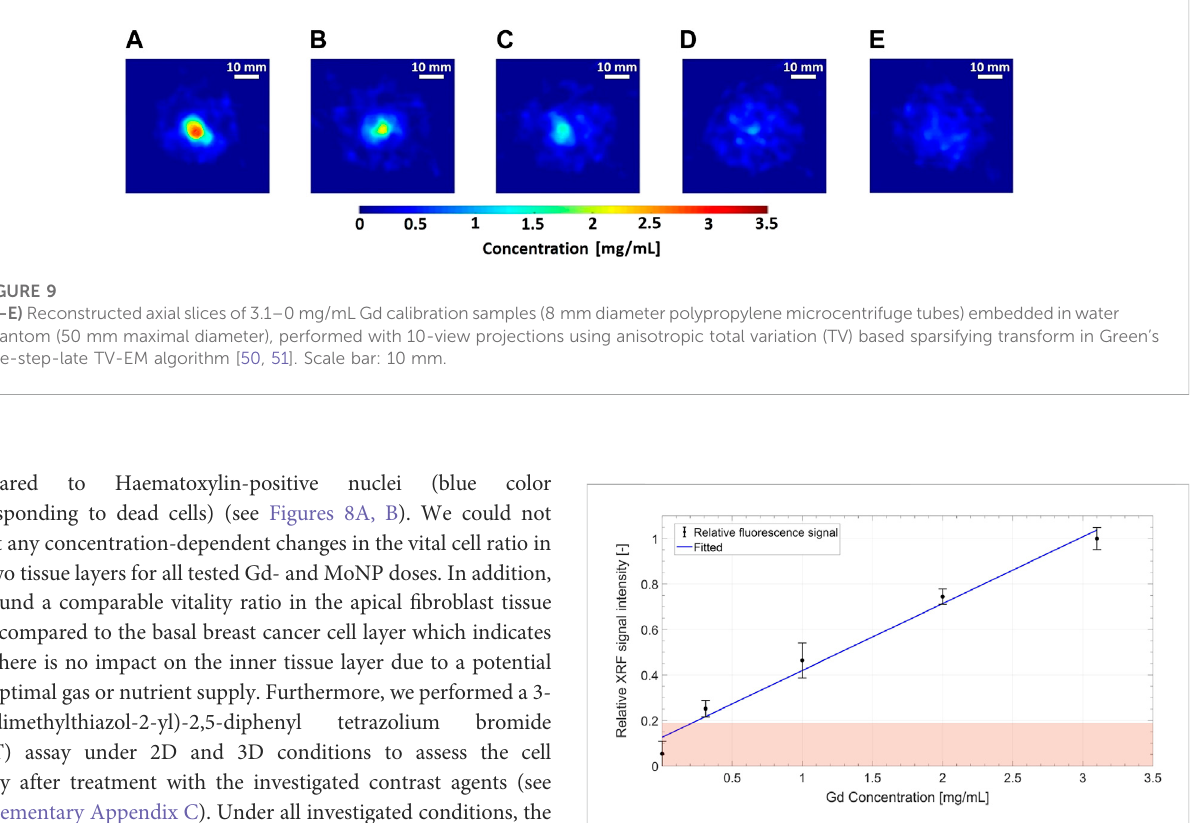
FIGURE 10 Calibration curve showing a linear increase in the relative (normalized by the maximum net XRF signal intensity) net XRF signal intensity with increasing Gd concentration. The boundary of the shaded zone represents the 3 σ (i.e., ~ 99 . 7 % ) background level above the intercept of the calibration curve. The XRF signals in this zone are not differentiable from the background noise, therefore, the detection sensitivity is de fi ned as the least detectable sample, i.e., 0.31